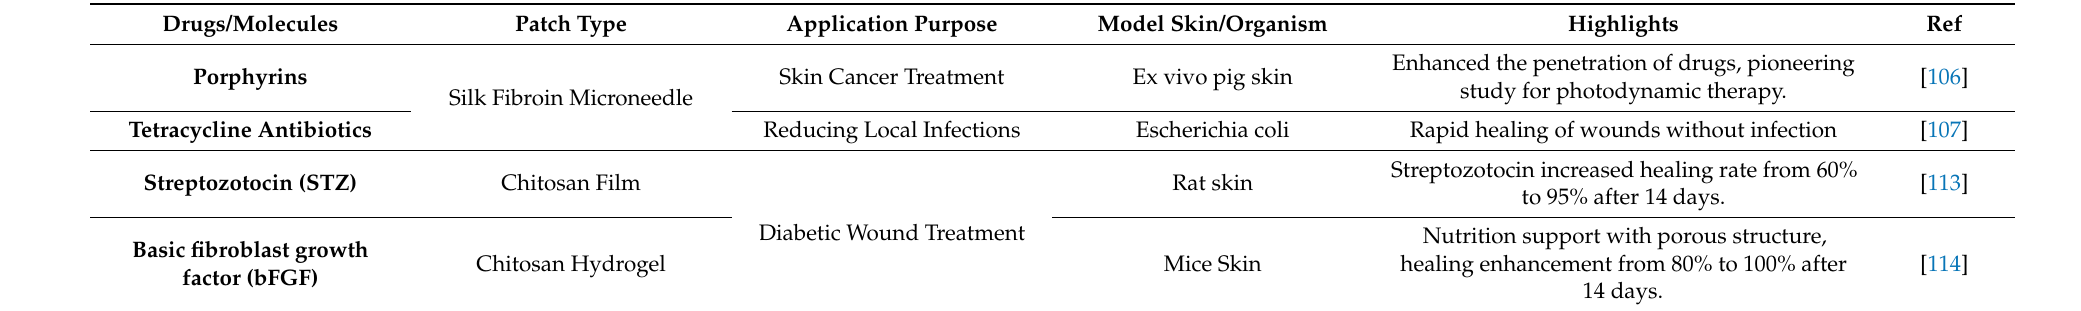
Table 5. Drug/molecules and patch types used in the treatment of skin